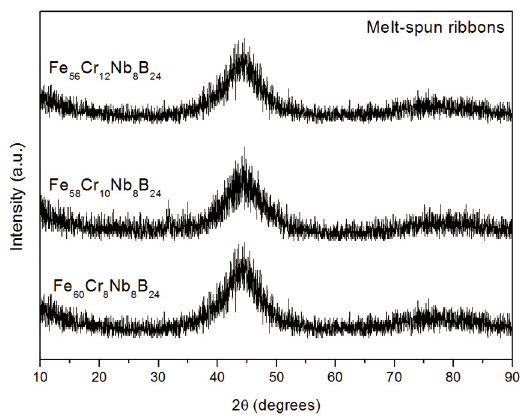
Figure 2: X-ray diffraction patterns for selected Fe-Cr-Nb-B alloys as-quenched ribbon.